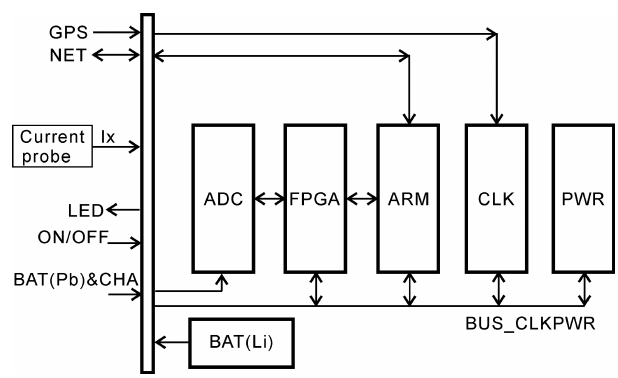
Figure 2. Block diagram of the current recorder.